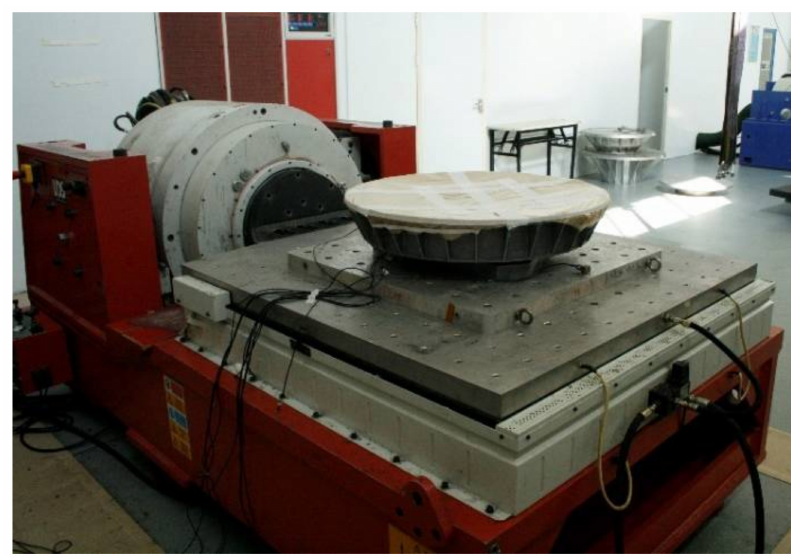
Figure 16. Vibration test of the primary mirror